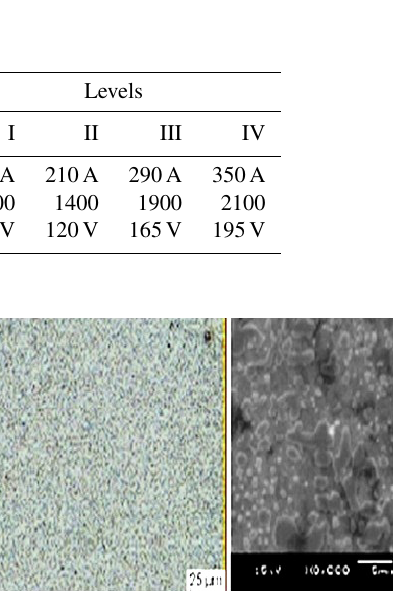
Figure 5. Cryogenically treated with tempering (CTT) of the elec- trode microstructure.